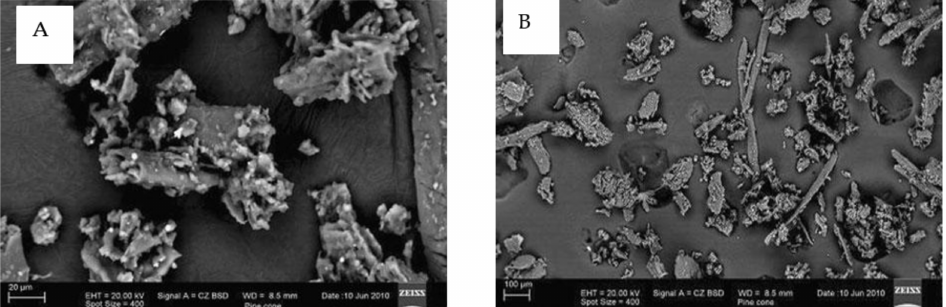
Figure 5. ( A ) SEM image of pinecone biomass before adsorption. ( B ) SEM image of pinecone biomass after MB adsorption